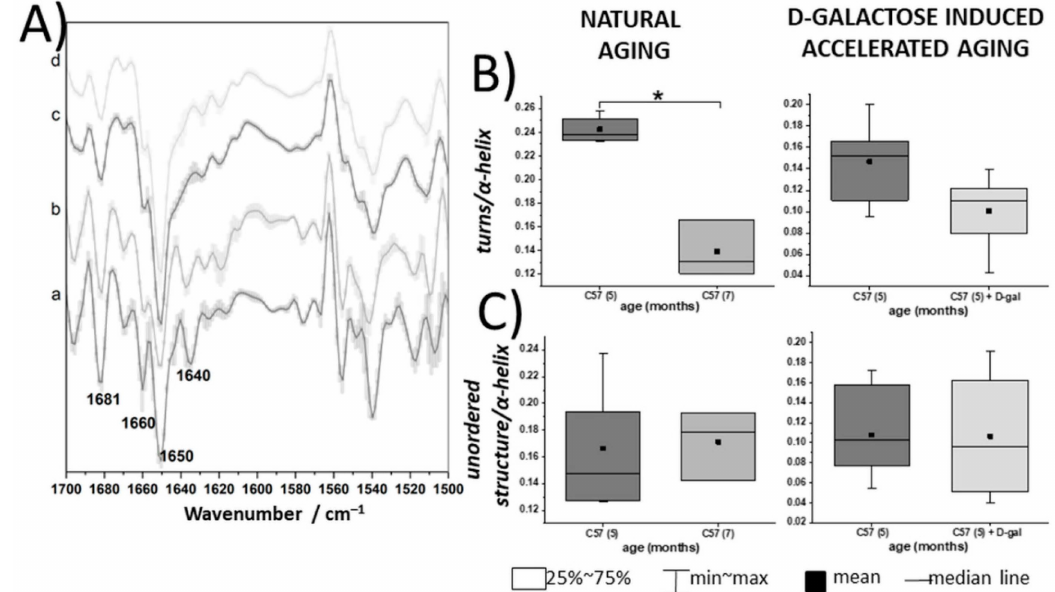
Figure 4. Spectroscopically derived biochemical profile of intact RBCs in natural aging and the D-gal model. ( A ) Second derivative FTIR–ATR spectra (with SD) of unfixed, intact RBCs taken from 5- and 7-month-old C57BL/6J mice (a and b, respectively) ( n = 3–4) and 5-month-old C57BL/6J mice ( n = 3) and treated with D-galactose (c and d, respectively) ( n = 3), displayed in the 1700–1500 cm − 1 spectral region; ( B , C ) ratios of the integral absorbances at 1660/1650 and 1640/1650 cm − 1 , respectively, comparing natural aging and a model of D-galactose-induced accelerated aging, in terms of alterations in the secondary structures of the RBC proteins, i.e., turns to α -helices and unordered conformations to α -helices, respectively. Normality was assessed using the Shapiro–Wilk test. The data are expressed as box plots (median and interquartile range) and the significance was calculated using a Mann–Whitney test (* p <